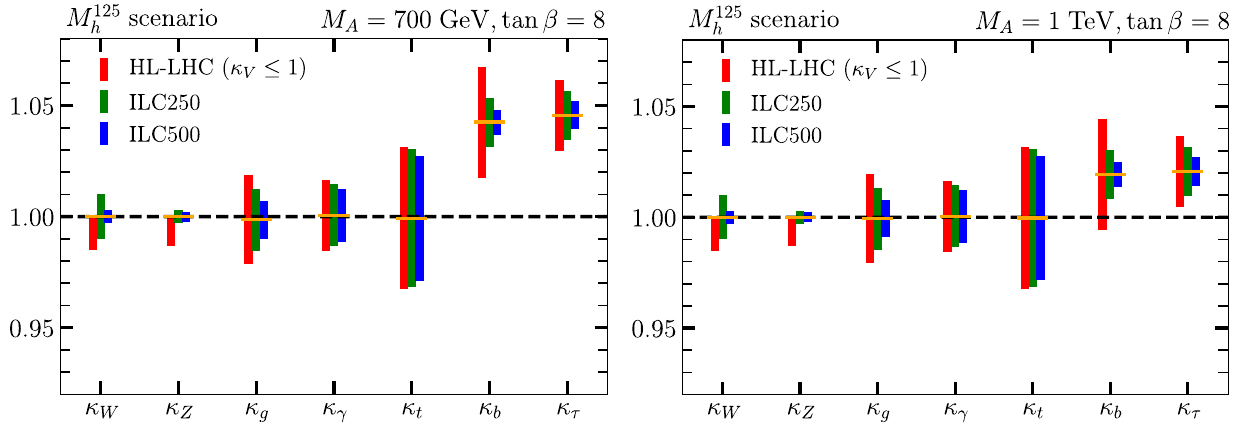
Fig. 9 Wäscheleinen-plots for the two assumed MSSM parame- 1 σ precision from a global fit [107] to Higgs rate measurements at ter points ( M A , tan β) = ( 700GeV , 8 ) (left) and ( M A , tan β) = the HL-LHC, where the theoretical assumption κ V ≤ 1 is employed, ( 1TeV , 8 ) (right) in the M 125 and including prospective measurements at ILC250 and ILC500 (but scenario: Predicted Higgs couplings in h without imposing an assumption on κ V the κ framework (orange horizontal bars) along with the anticipated